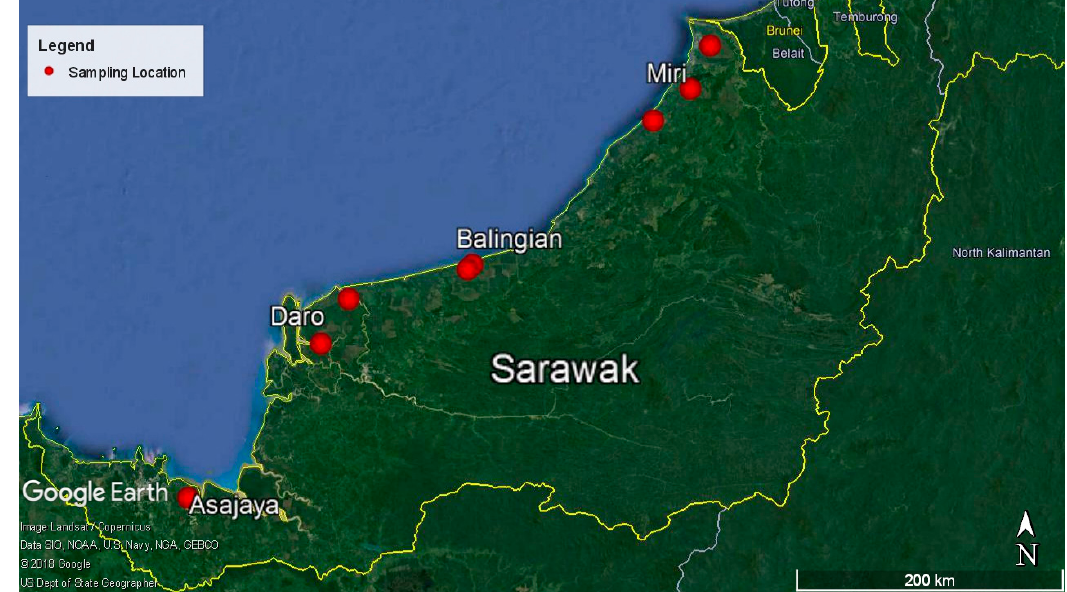
Figure 3. Sampling locations of Ganoderma basidiomata across oil palm plantations in Sarawak. Map extracted from Google Earth [62].